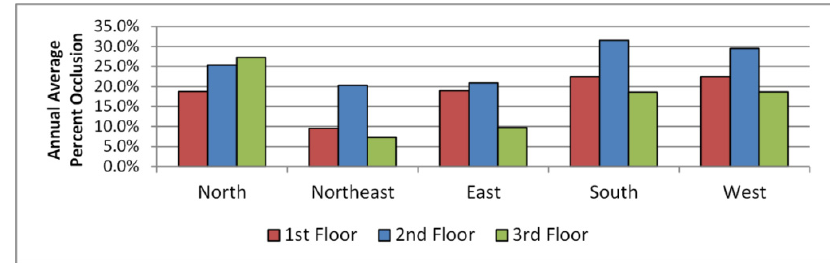
Figure 18. Annual average percent occlusion (DGI 20 ).